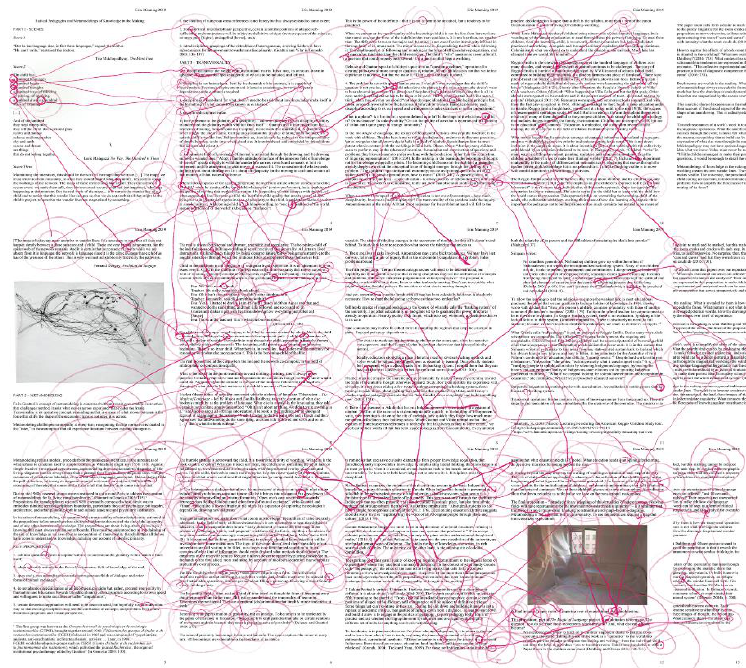
Figure 4 ; Definite and indefinite